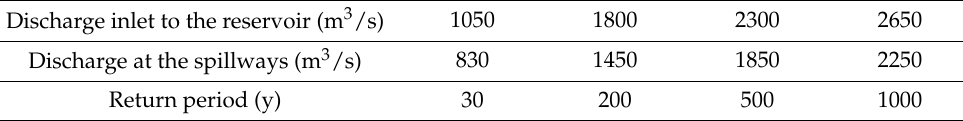
Table 2. Characteristic discharge values and return periods of the Liscione dam catchment